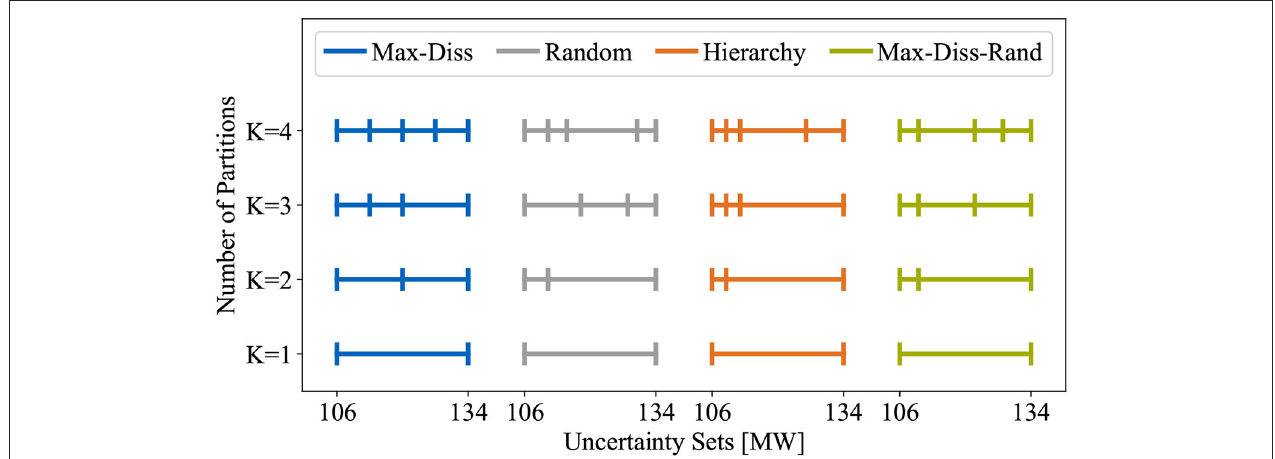
FIGURE 6 | Partitions of the uncertainty set for four different partitioning schemes.